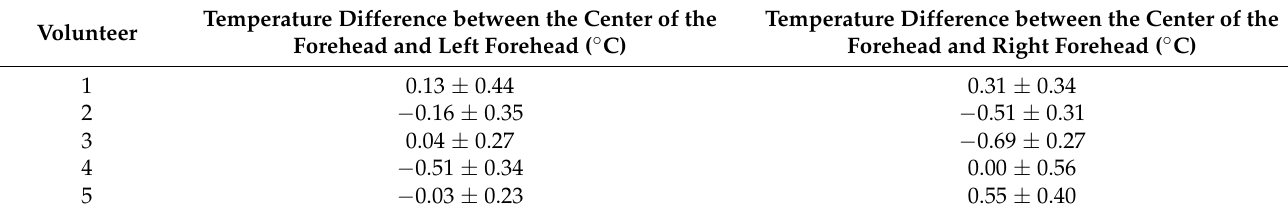
Table 1. Variations in the forehead temperature measured from the center and lateral positions of the forehead of five volunteers using our IR thermometer prior to the compensation adjustments.